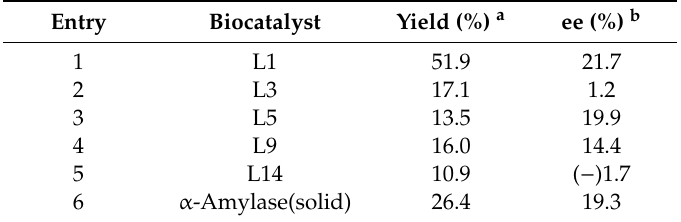
Table 5. Rescreening of lipase library using optimized reaction conditions.